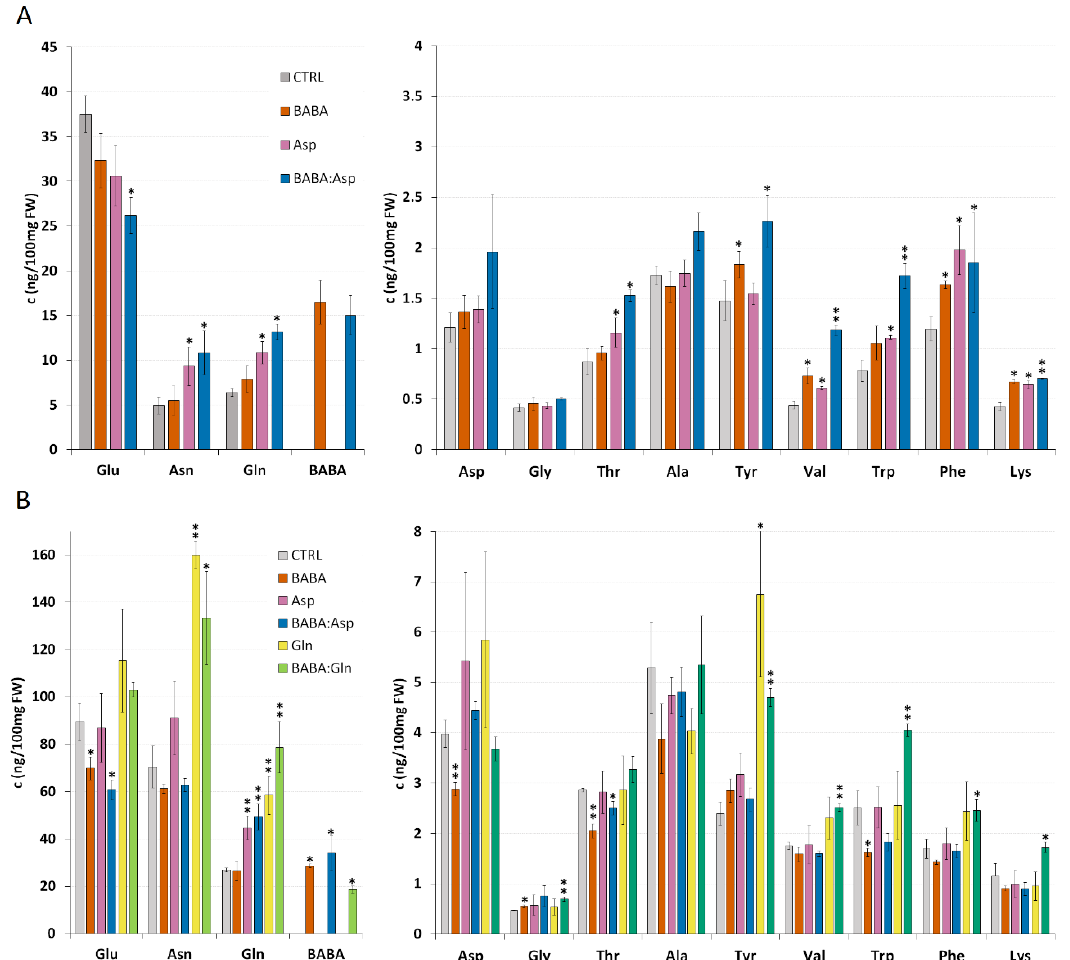
Figure 2. Amino acid levels in tomato plants. Amino acid levels of 8-week-old leaflets of Solanum lycopersicum cv. MicroTom ( A ) and Solanum lycopersicum cv. Amateur ( B ) plants. Leaflets were treated for 24 h with BABA or amino acids solutions (BABA, L-Asp, BABA: Asp, L-Gln, BABA: Gln), and amino acid levels were measured by the HPLC method. Data are means from free biological replicates for each time; the errors represent standard errors of means. Statistically, significant differences recorded for each amino acid as determined by t-tests are annotated with different asterisks (* p < 0.05, ** p <